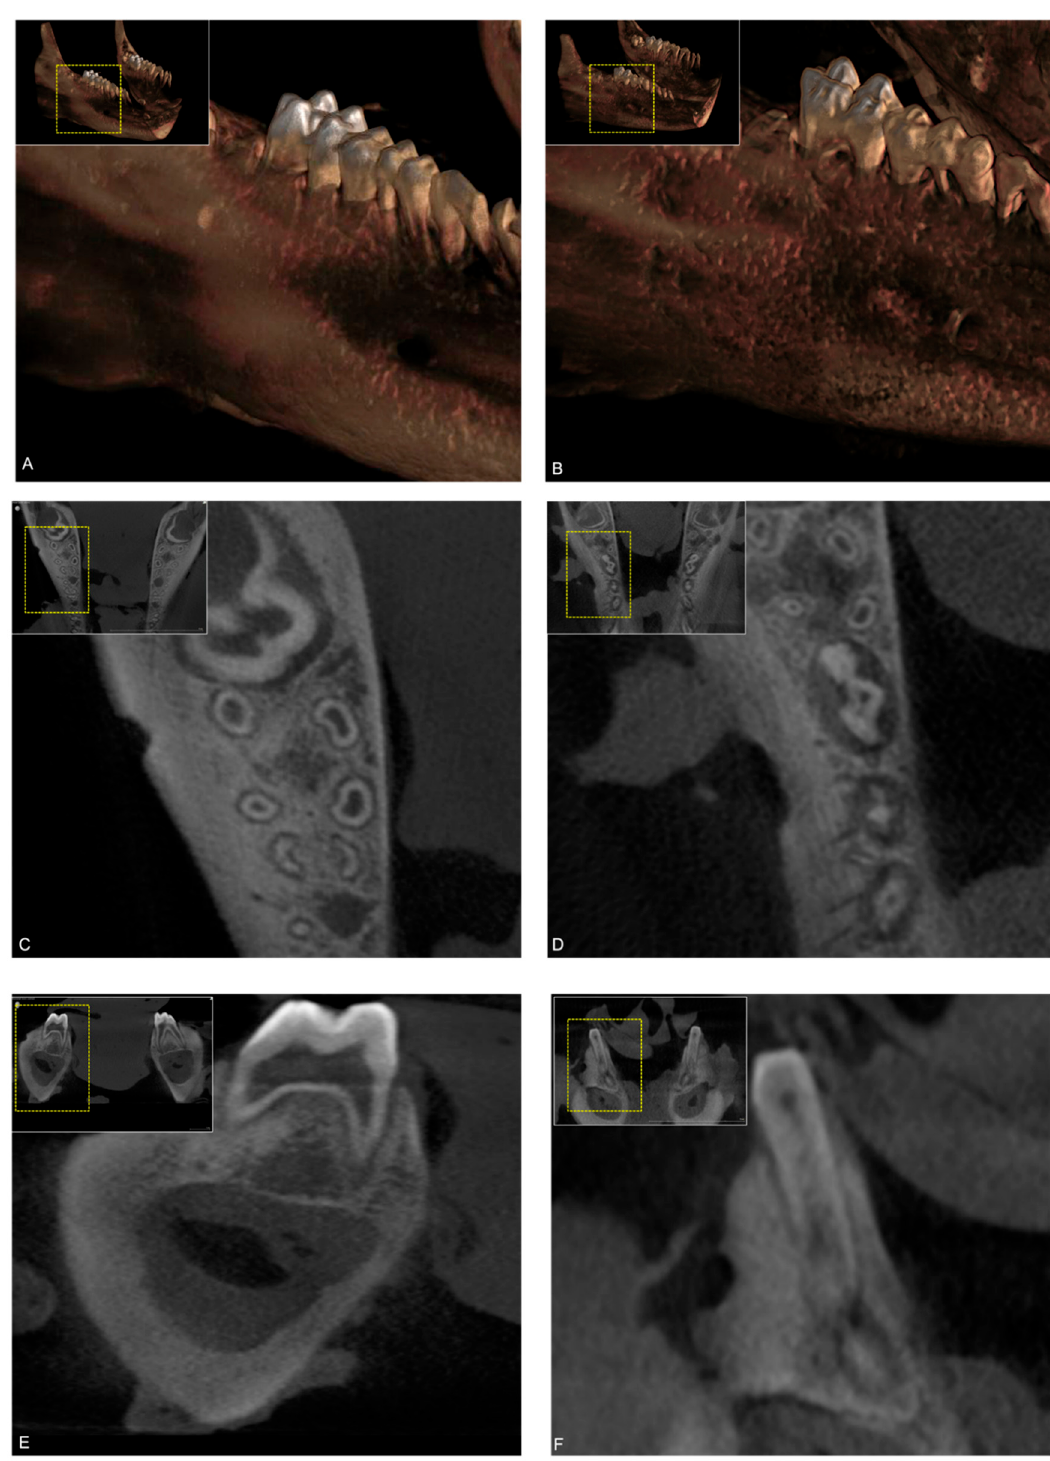
Figure 4. Screenshots of the cystic lesions visualized using the standard ‐ dose (upper row) (image reconstruction ( A ), axial ( C ), and coronal ( E )) and low ‐ dose (lower row) (image reconstruction ( B ), axial ( D ), and coronal ( F )) cone ‐ beam computed tomography (CBCT) imaging protocols.